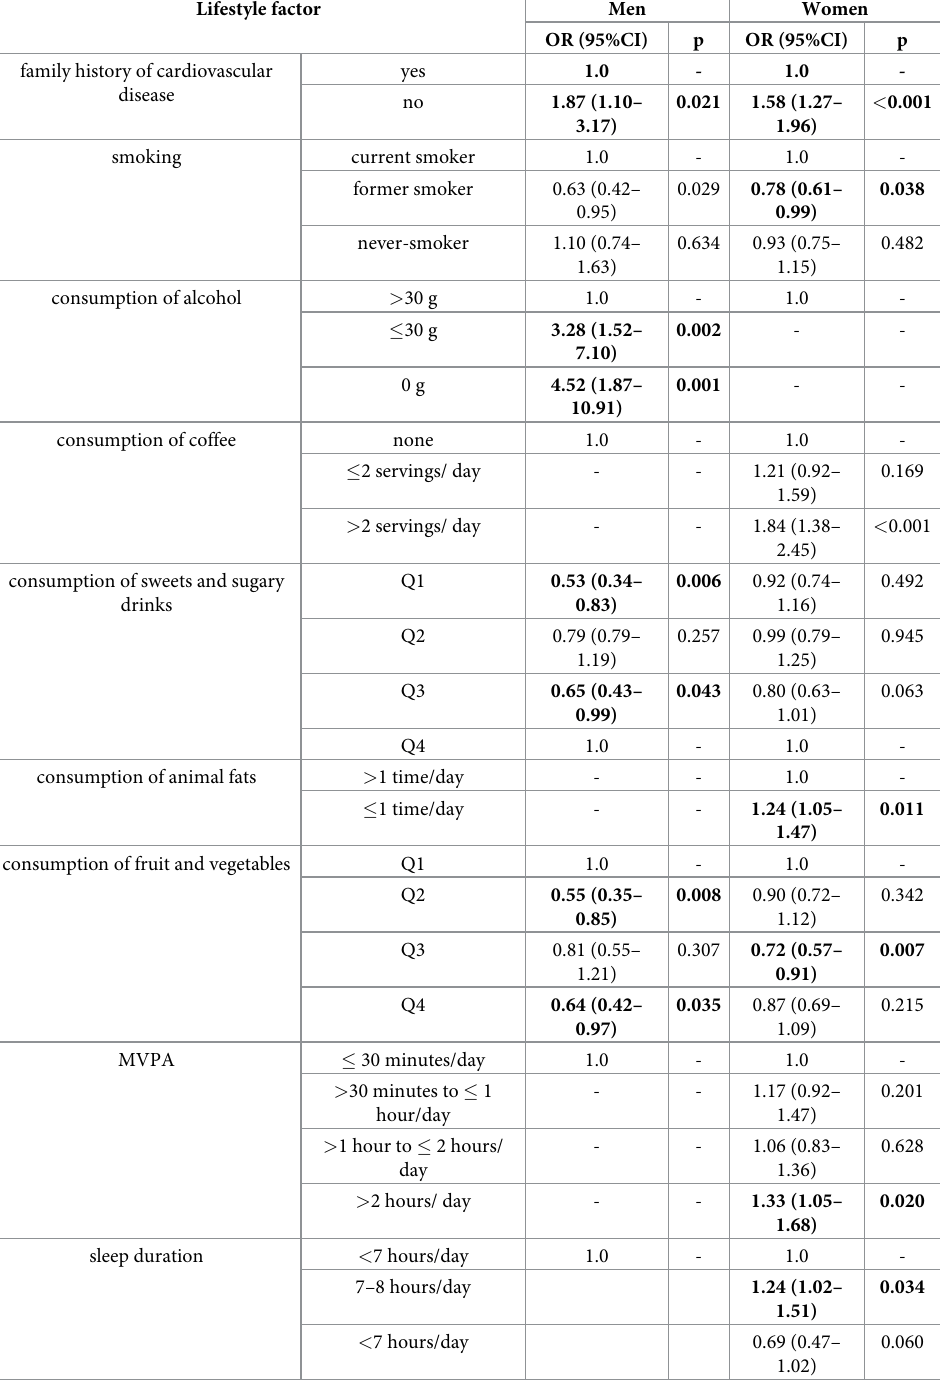
Table 4. Factors associated with metabolic health. Multivariate analyses with backward stepwise selection results for � 2 components of MetS in men and